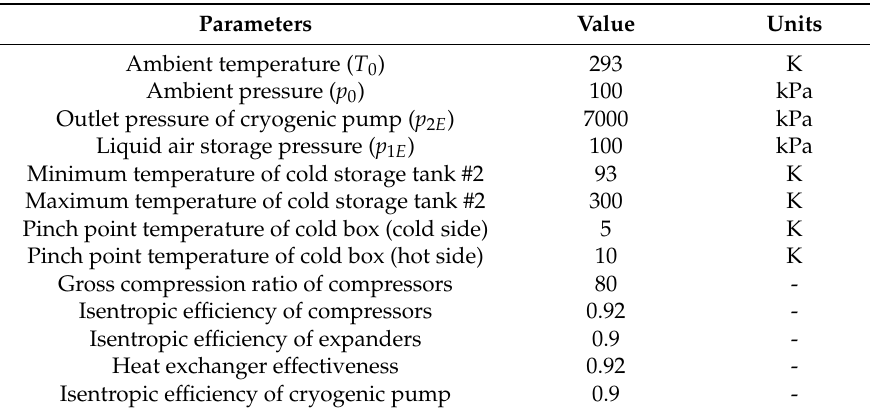
Table 1. Basic operating parameters of the system.